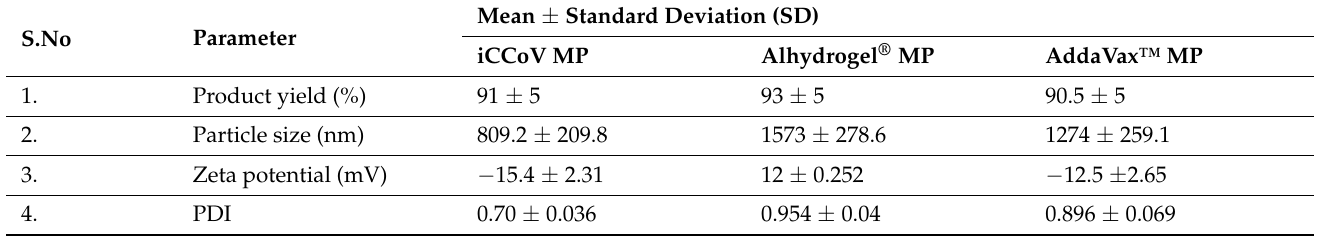
Table 2. Characterization results of vaccine and adjuvant MP.